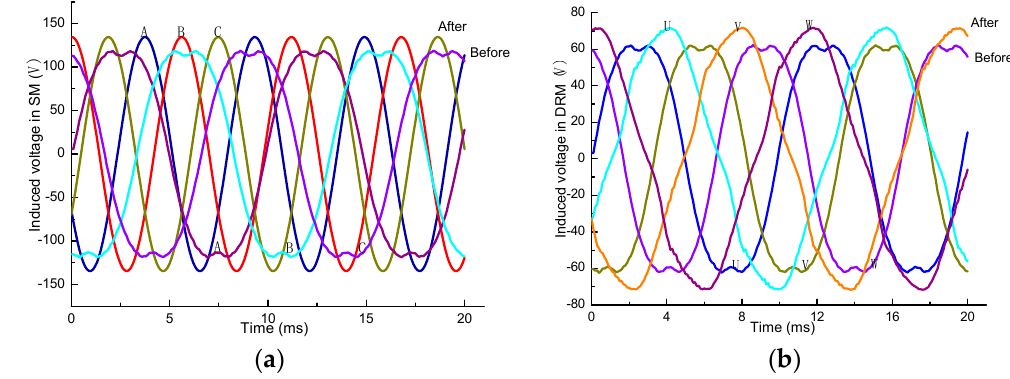
Figure 15. Induced voltage of stator windings and inner rotor windings: ( a ) Stator windings; ( b ) Inner rotor windings.